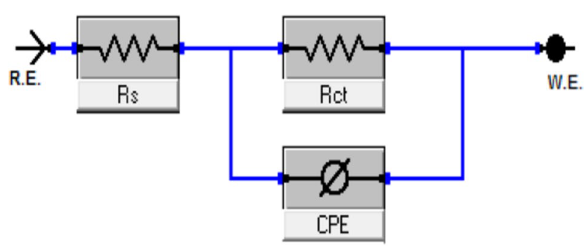
Figure 8. Electrical equivalent circuit model used to fit the impedance spectral